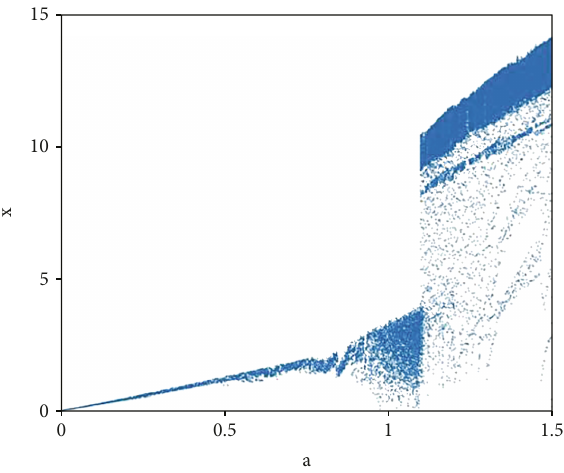
Figure 6: The bifurcation diagram.